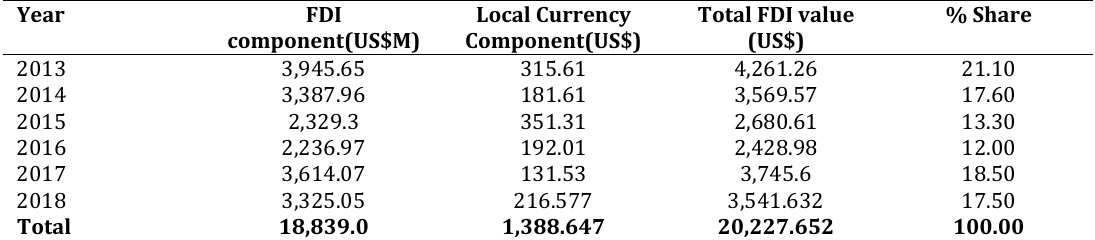
Table 1: Breakdown of FDI values to Ghana from 2013 to 2018